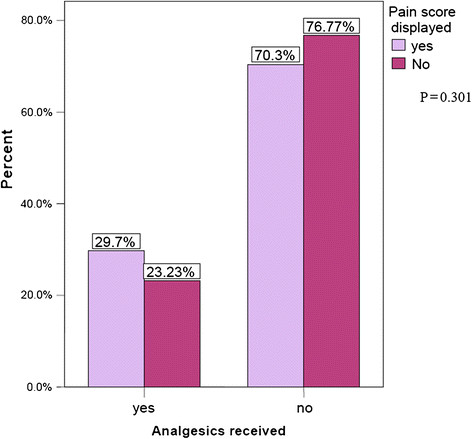
Bar chart showing percentage of patients who received analgesics in trial versus control group.